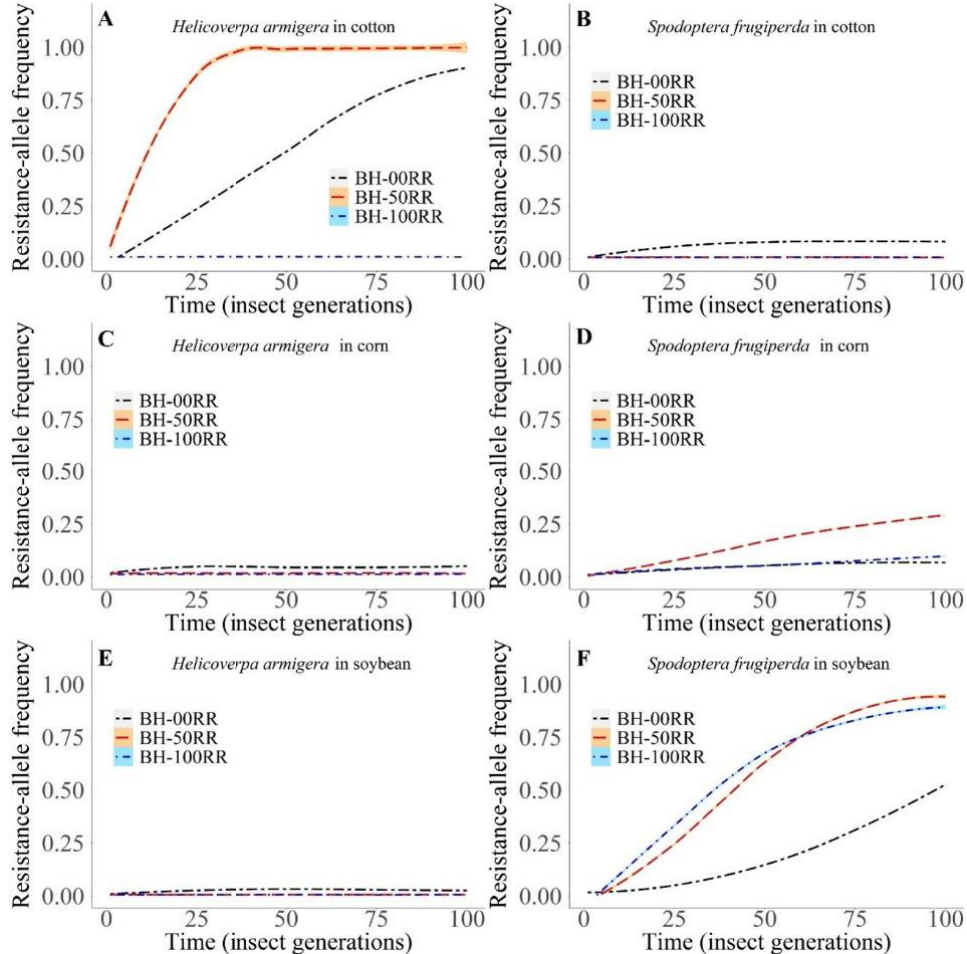
Figure 6. Absolute frequency of Spodoptera frugiperda and Helicoverpa armigera strains in intra- and interspecific interactions in cotton, corn, and soybean plants in the following scenarios of heterozygous behavior (BH): BH-00 RR, competition behavior of the heterozygote 100% equal to the susceptible ones; BH-50 RR, competition behavior of the intermediate heterozygote, i.e., 50% equal to the susceptible and 50% equal to the resistant individuals; BH-100RR, competition behavior of the heterozygote 100% equal to the resistant ones. ( A ) H. armigera in cotton. ( B ) S. frugiperda in cotton. ( C ) H. armigera in corn. ( D ) S. frugiperda in corn. ( E ) H. armigera in soybean. ( F ) S. frugiperda in soybean.